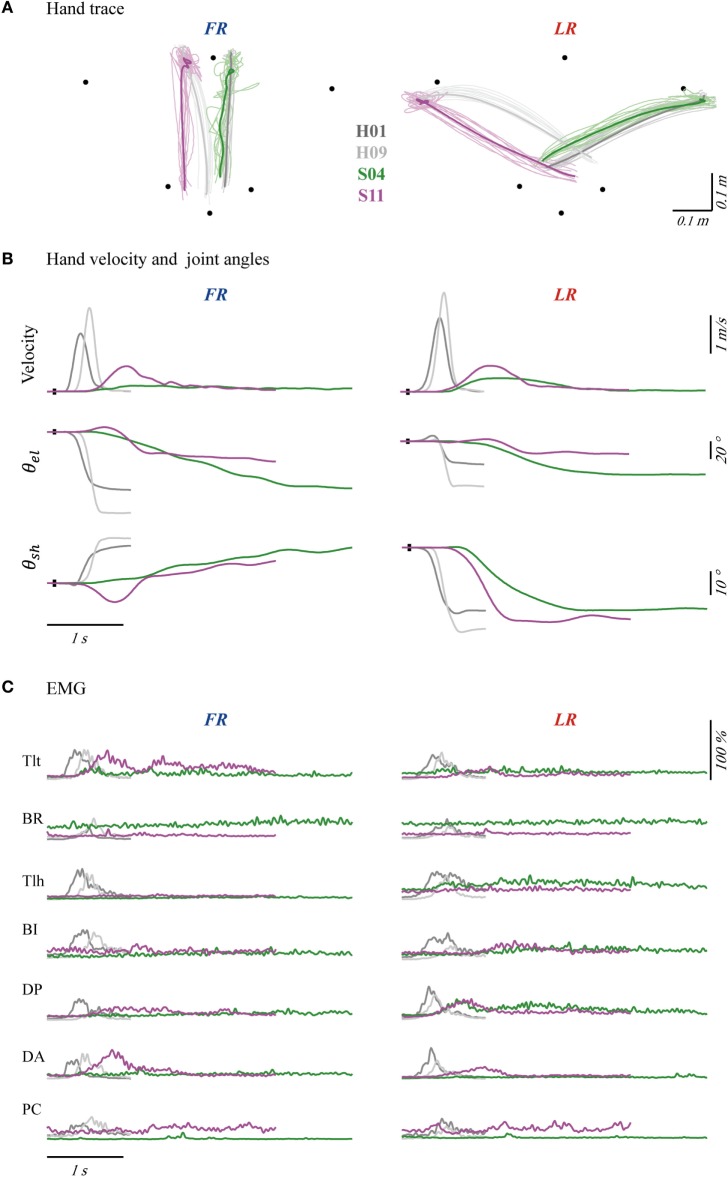
Hand traces (A), hand velocities and joint angles (B), and seven channels of averaged electromyography (EMG) (C) of four typical subjects, with forward reaching (FR) in the left column and lateral reaching (LR) in the right column. The bold profiles in (A) represent averaged trajectories. The black dots on profiles of velocity and angle indicate trigger tag. θel and θsh were angles of elbow and shoulder joint. Initial angles of shoulder and elbow were calibrated to mean of the four subjects’ angles. Each channel of EMG was normalized according to its maximal firing level among trials in each task. The EMGs were collected from pectoralis clavicular (PC), anterior deltoid (DA), posterior deltoid (DP), biceps (BI), triceps long head (Tlh), Brachioradialis (BR) and triceps lateral head (Tlt).